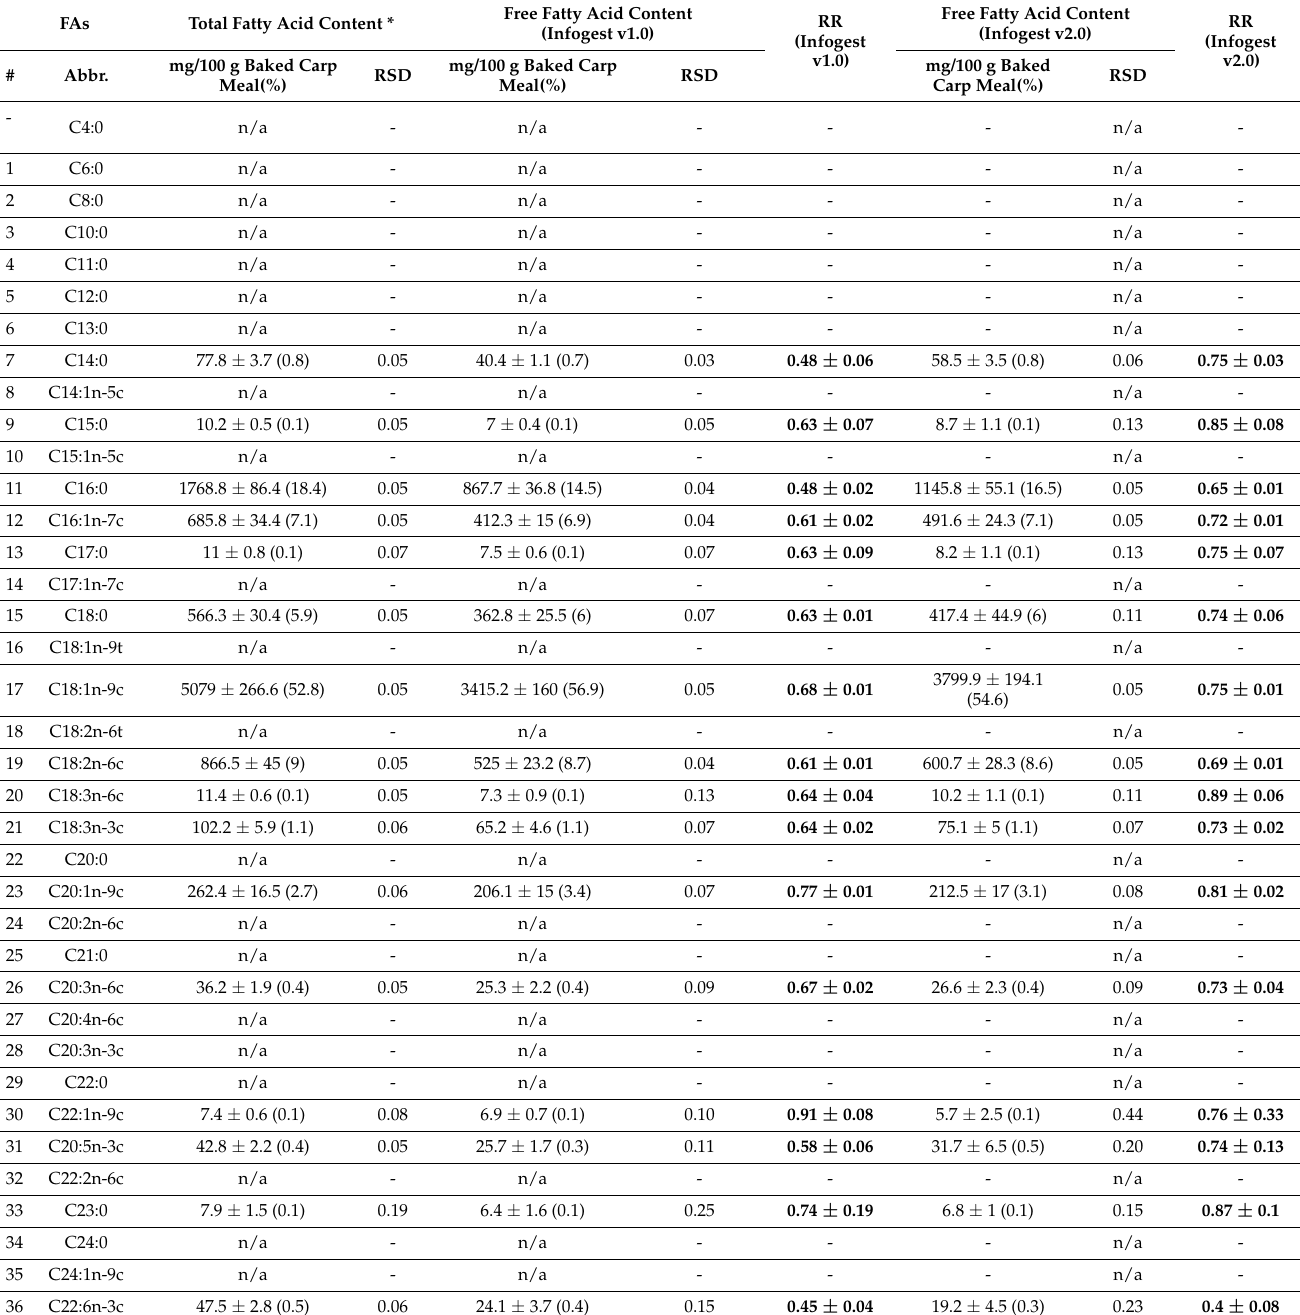
Table 2. Fatty acid composition of the baked carp meal’s small intestinal digesta: total fatty acid content and free fatty acid content in mg/100 g baked carp meal (calculated according to Equation (1)) via Infogest v1.0 and v2.0. Contribution of the given FA in % is shown in parentheses. Release ratio (RR) of individual fatty acids was calculated according to Equation (2) via Infogest v1.0 and v2.0 (results are presented in